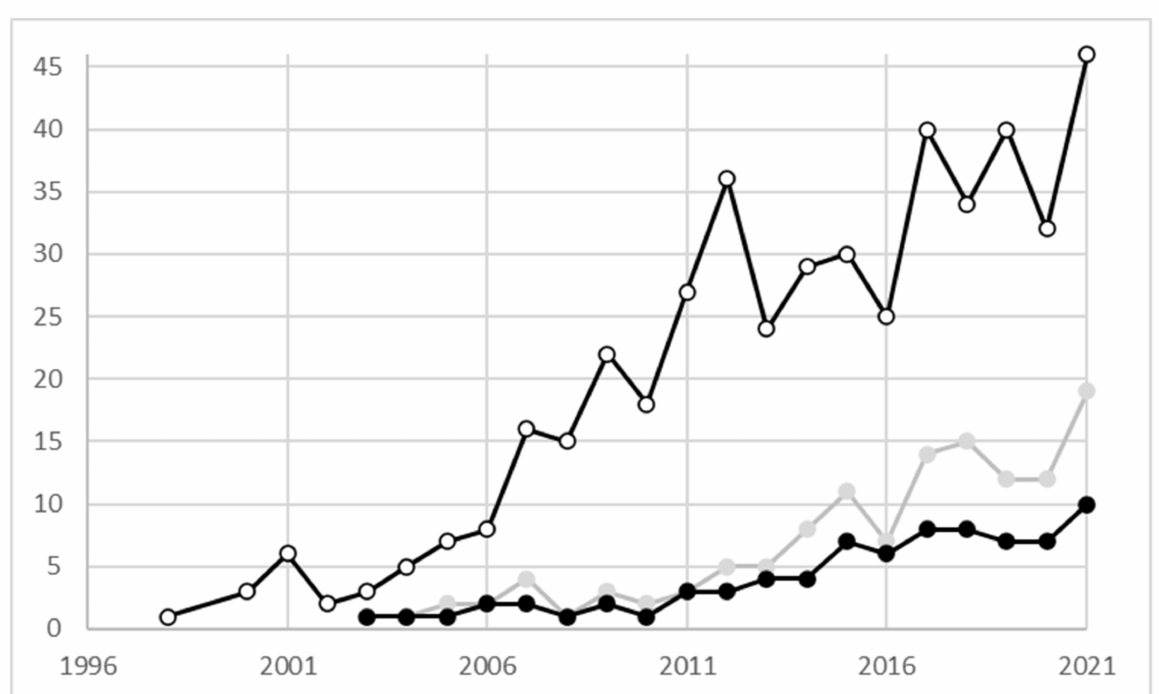
Figure 3. Search results using Scopus; results showing all the documents obtained using the keywords “plant conservation”, “phylogeography” and “Mediterranean”, and the criterion “AND” that forced the results to include the three keywords (463 documents; black line/white dots); results showing research papers that are plant related in which conservation actions considered the phylogeographic patterns (127 documents; grey line/grey dots); papers with focus on the MTEs (78 documents; Black line/black